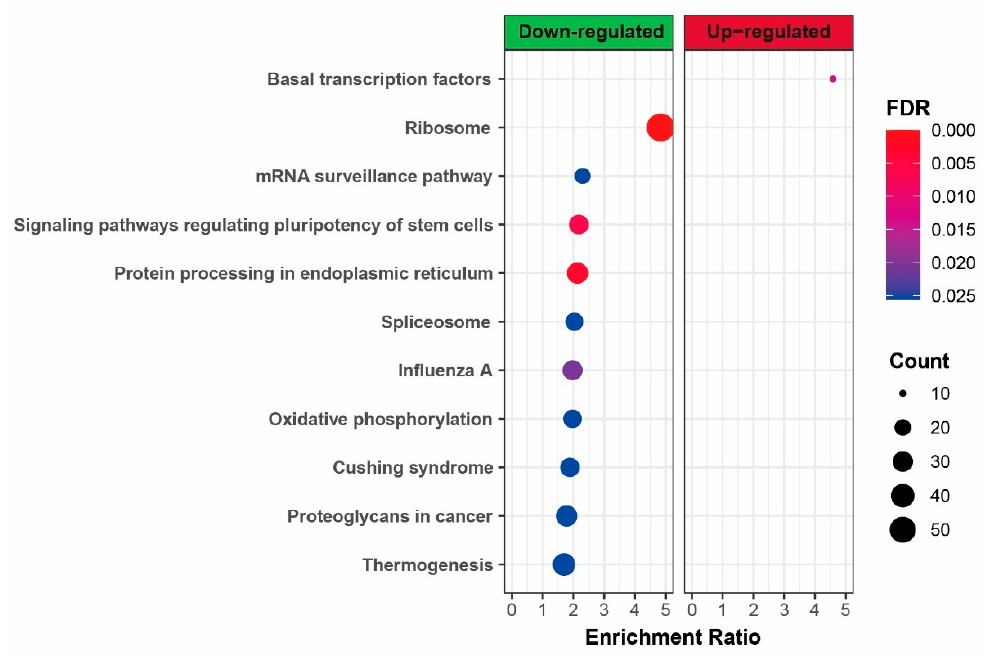
Figure 3. KEGG pathway enrichment analysis of upregulated and downregulated DEGs. The top 10 KEGG pathways that were significantly enriched for downregulated DEGs are listed. Only one pathway was enriched for upregulated DEGs.